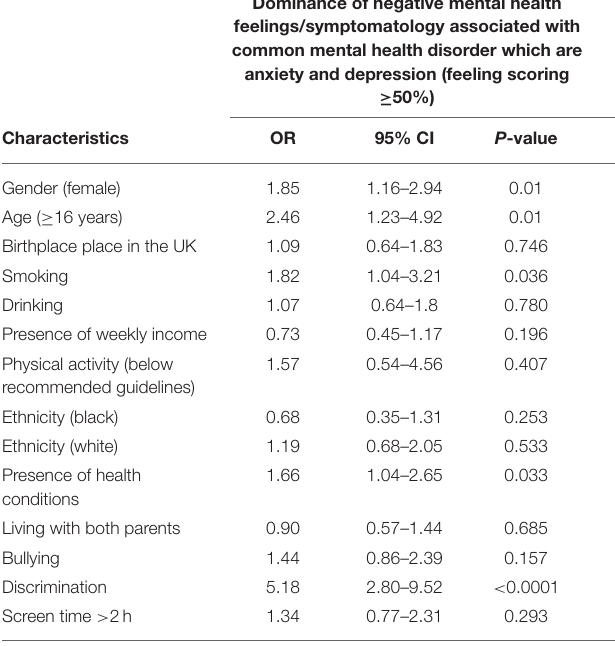
TABLE 4 | Binary logistic analysis for risk factors affecting mental health in adolescents. Dominance of negative mental health feelings/symptomatology associated with common mental health disorder which are anxiety and depression (feeling scoring ≥